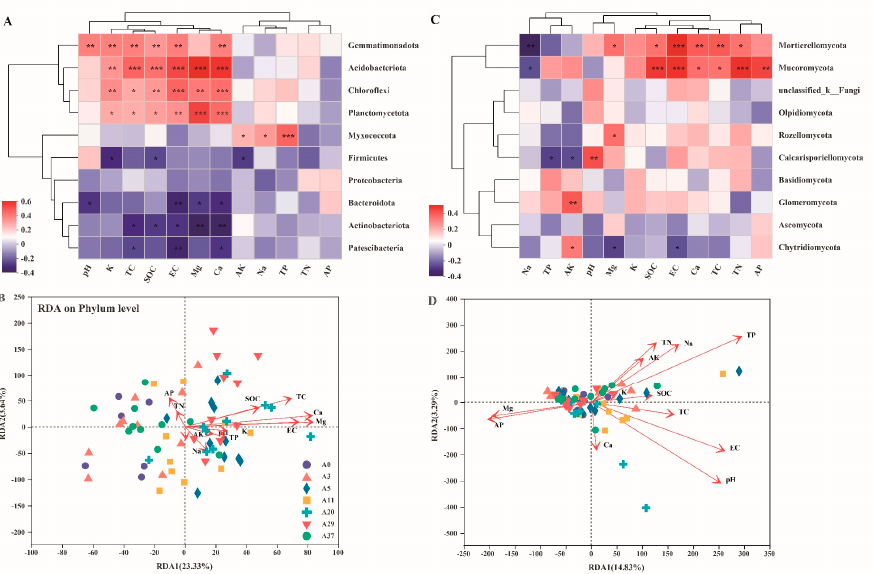
Figure 5. Spearman correlation heatmap and redundancy analysis (RDA) of the relationships between the dominant phyla (top 10) of bacteria ( A , B ) and fungi ( C , D ) and soil physicochemical properties fi ltered by variance in fl ation factor (VIF) for a ff orestation by aerial sowing in the northeastern Tengger Desert, China. Values on the x − and y − axes and the length of the corresponding arrows represent the importance of each soil physicochemical property in explaining the distribution of taxa across communities. Signi fi cance level, * p < 0.05, ** p < 0.01, *** p < 0.001.